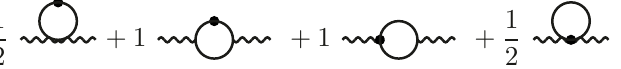
Figure 2 . 1-loop contributions to the 2-point function, containing some of the “Chapman vertices” from eq. (2.13), denoted by a filled blob. The adjoint scalar fields are denoted by solid